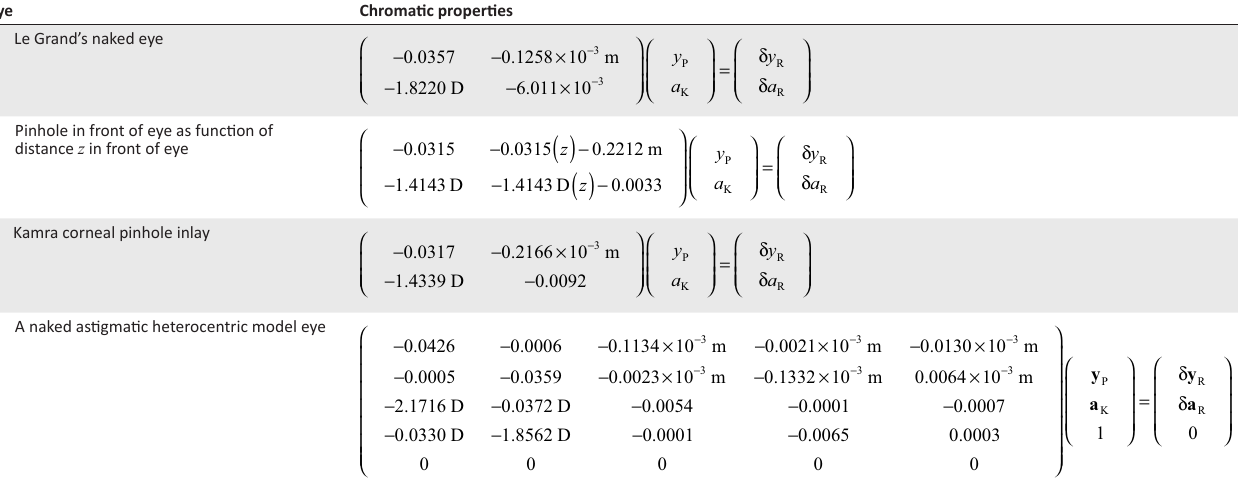
) and aperture ( y ) position (Equation 2). K P y a a